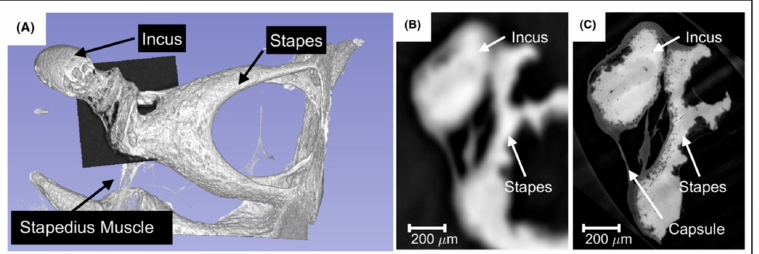
Figure 7. ( A ) 3D rendered volume of the incus and stapes from the 9 μ m scan. Axial slice through the ISJ at 9 μ m scan ( B ) and 0.9 μ m scan ( C ). The 0.9 μ m clearly demonstrates high contrast between the bone and the surrounding soft tissue. Reprinted with permission from